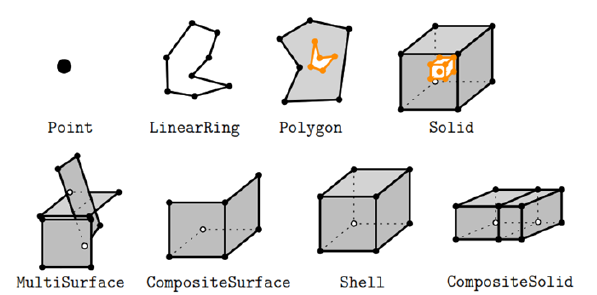
Figure 1 . The 3D geometric primitives are used in CityGML (Biljecki et al., 2016).